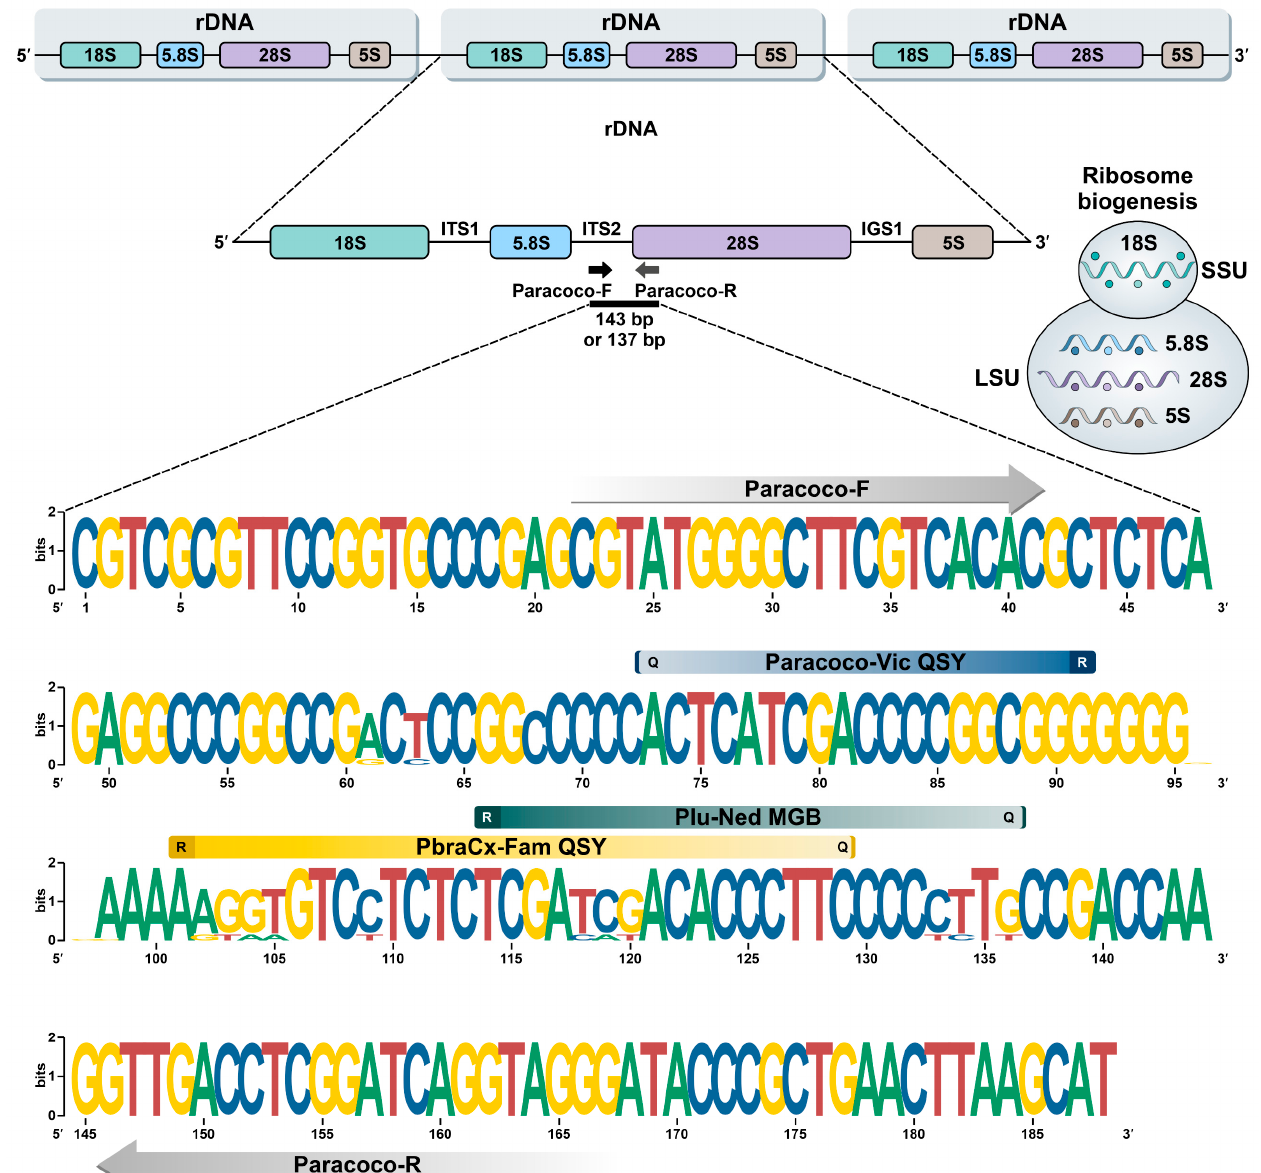
Figure 1. Graphic representation using WebLogo of polymorphism patterns within the alignment of 31 target sequences of members of the P. brasiliensis complex and P. lutzii (see Supplementary Table S2). Paracoco-F and Paracoco-R primers recognize a highly conserved region for Paracoccidioides species with no mismatches. Parsimony-informative sites in the ITS2 region uncovered candidate areas for DNA-based FRET probes design, i.e., PbraCx-Fam, Plu-Ned, and Paracoco-Vic. R: reporter; Q: quencher.